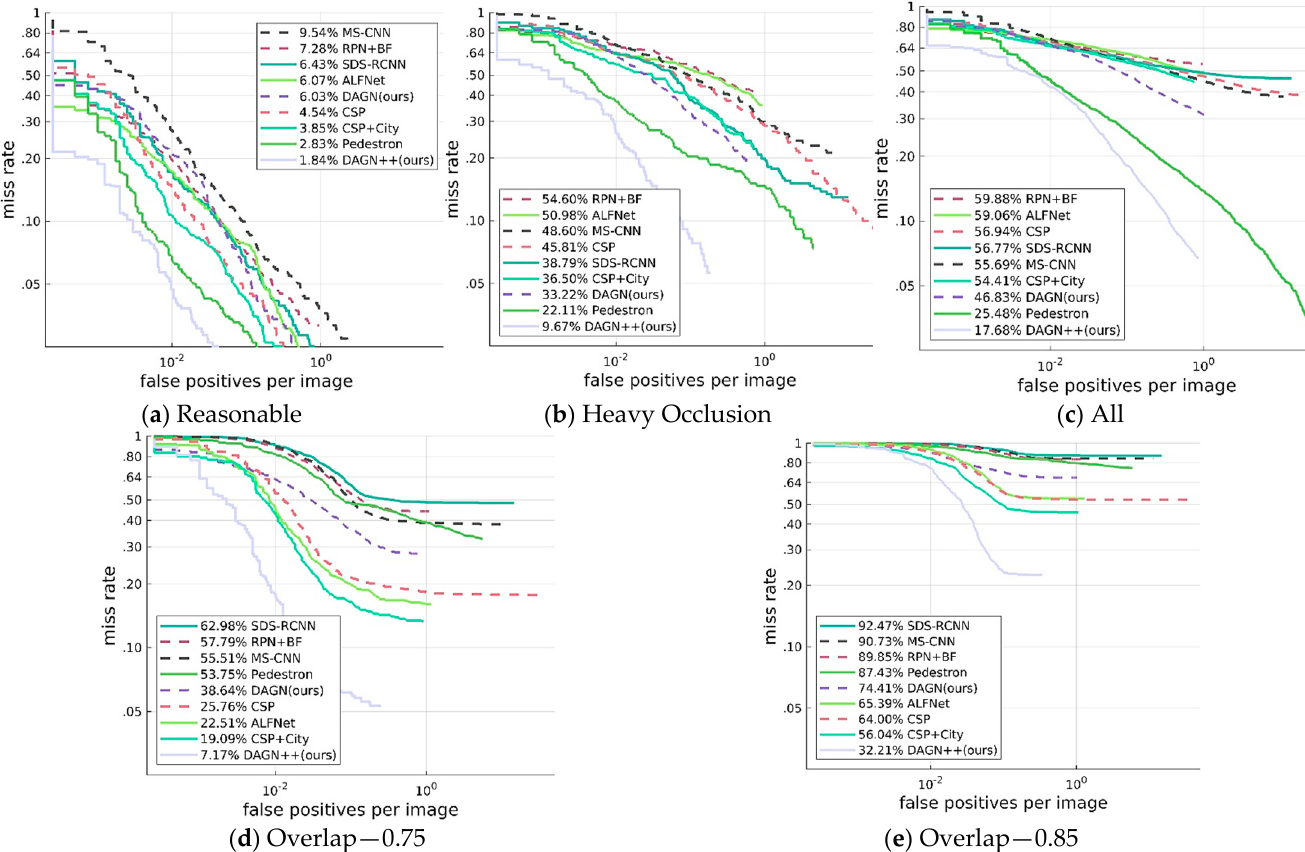
Figure 7. Quantitative comparison results of the Caltech testing set with five subsets: ( a ) Reasonable. ( b ) Heavy occlusion. ( c ) All. ( d ) Overlap—0.75. ( e ) Overlap—0.85.